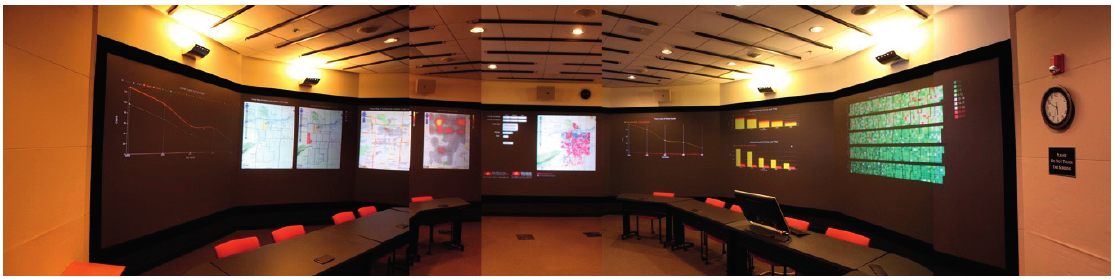
Figure 12. PySAL delivered in the Complex Systems Framework web-based decision support